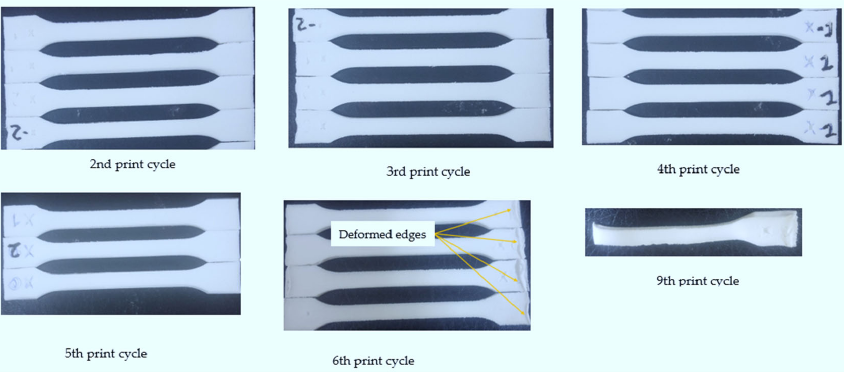
Figure 7. Printed tensile test specimens for different re ‐ use powder cycles.